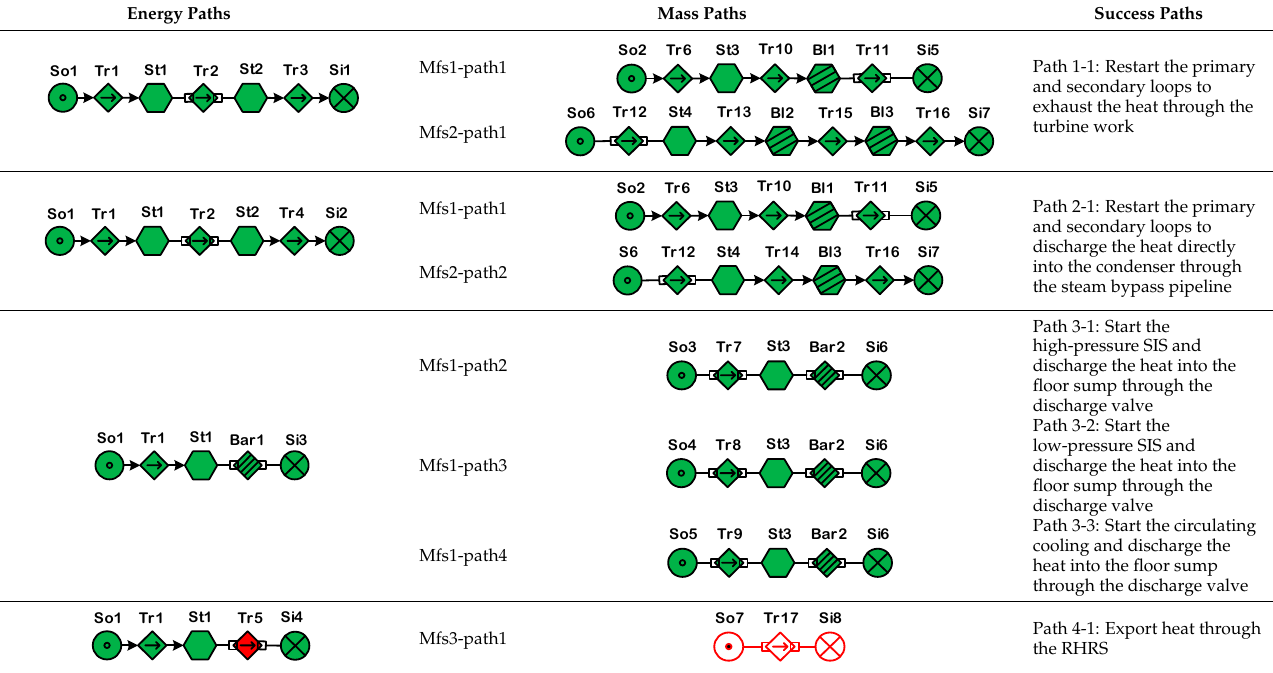
Figure 8. Paths identi fi ed from the MFM model in Figure 7. The path in the red boxes is not available, The path in the yellow boxes have hidden danger.